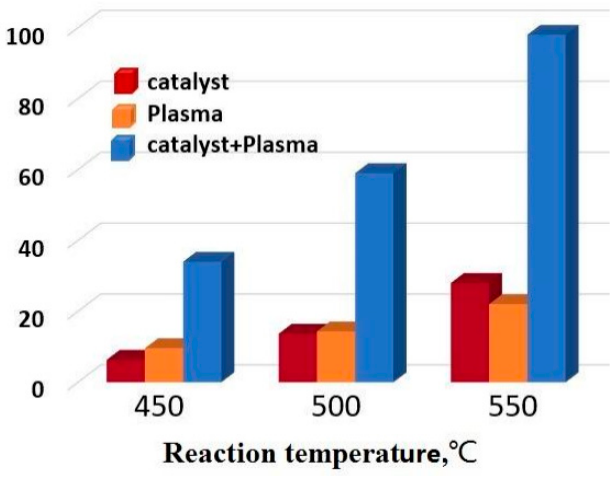
Figure 17. Comparison of the efficiency of three methods of hydrogen production by ammonia decomposition at different temperatures.